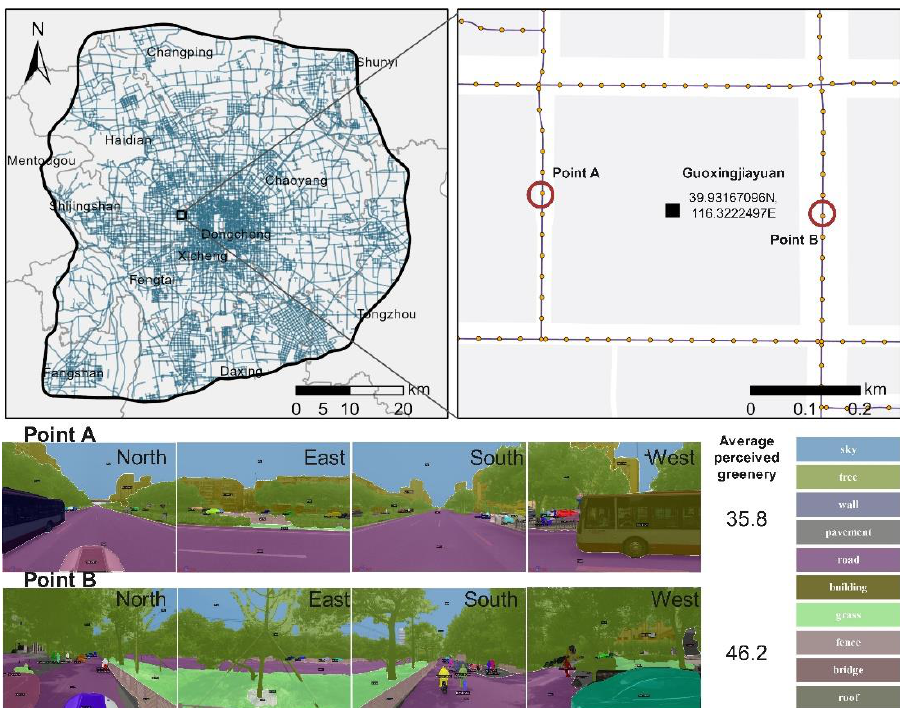
Figure 3. The location of the Guoxingjiayuan community and perceived greenery measurement examples. The vermilion circles in the enlarged map indicate points A and B adjacent to the plot and the corresponding street views used in panoptic segmentation masks.